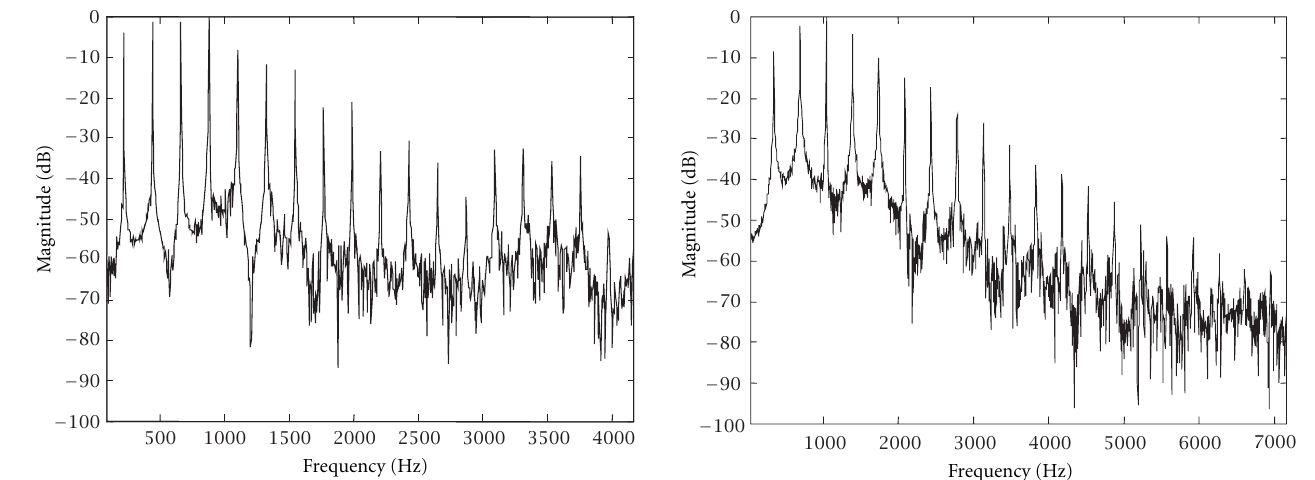
Figure 14: Real-life oboe (287.5 Hz).